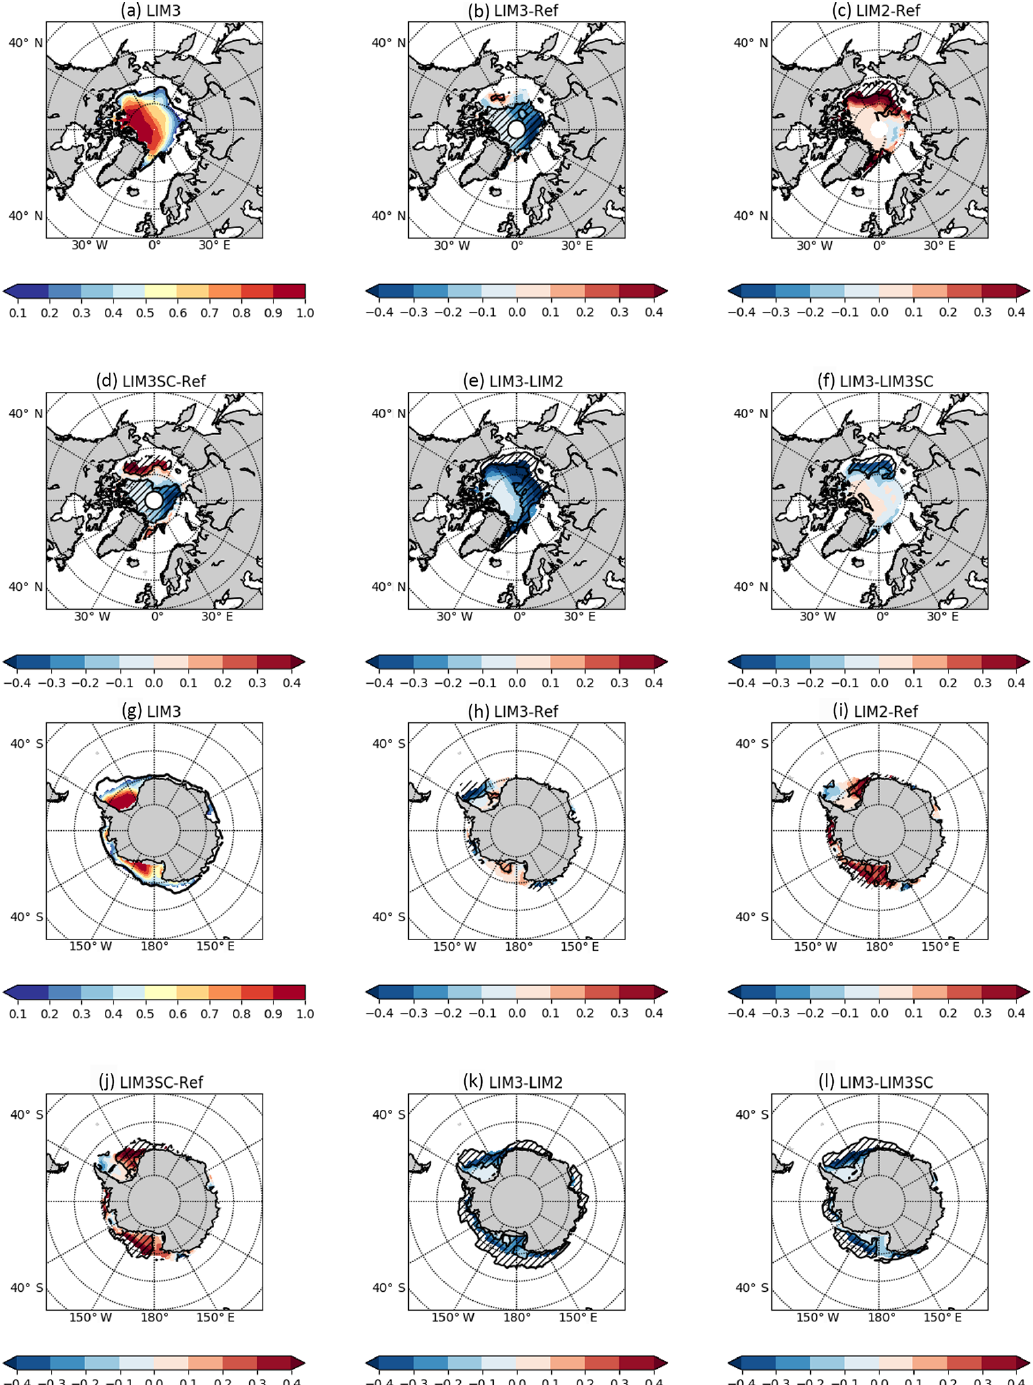
Figure 1. Geographical distribution of Arctic sea-ice concentration averaged for September (a–f) and Antarctic sea-ice concentration av- eraged for March 2003–2012 (g–l) . (a, g) show values simulated by LIM3, while (b, h) show LIM3 difference with Meier et al. (2013) passive microwave observations, (c, i) the corresponding LIM2 difference, (d, j) the LIM3SC difference, and (e, k) show the difference between LIM3 and LIM2 and (f, l) the difference between LIM3 and LIM3SC. Sea-ice concentration differences are computed only where both values are present. Only areas where the sea-ice concentration is greater than 15% are plotted. In (a, e) , thick black lines show the observed Meier et al. (2013) sea-ice edge as the 15% sea-ice concentration isopleth. Hatching indicates regions with statistically significant differences at the 5% level, based on unequal variance t